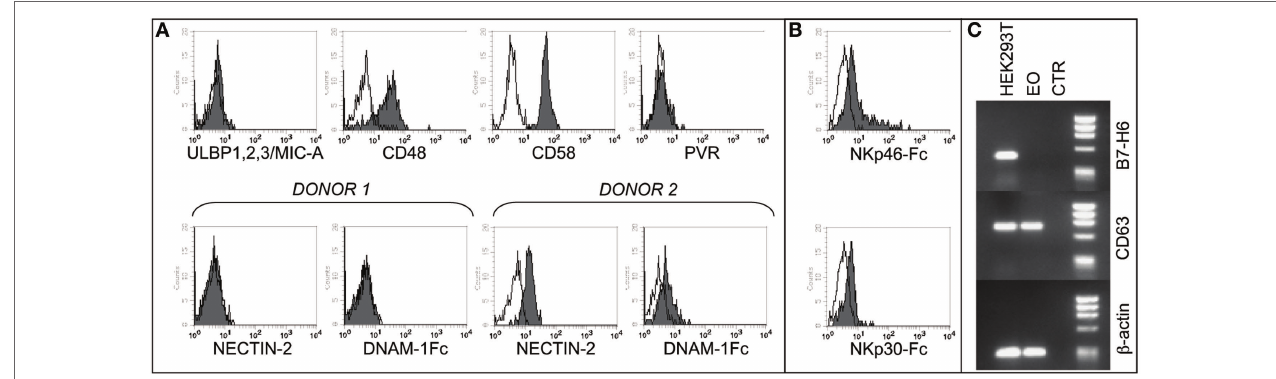
FigUre 1 | analysis of nK cell receptor ligands on eosinophils (eOs) freshly purified from healthy non-atopic donors . (a) EOs were analyzed for the cell surface expression of NK cell receptor ligands including ULBP1,2,3, MIC-A, CD48, CD58, and PVR. A representative donor out of 15 is shown (upper line). The expression of Nectin-2 and, as control, the staining with DNAM-1-Fc* soluble molecule are shown for two representative donors out of 20 analyzed (lower line). Open profiles indicate staining with the corresponding PE-conjugated anti-mouse or anti-human secondary reagents. (B) EOs were analyzed for the cell surface binding of NKp30-Fc* and NKp46-Fc* soluble molecules. Open profiles indicate staining with PE-conjugated anti-human IgG secondary reagent. A representative donor out of six is shown. (c) B7-H6 mRNA expression was assessed by RT-PCR in EOs and in HEK293T cell line. PCR products were run on a 0.8% agarose gel and visualized by ethidium bromide staining. RT-PCR was also performed with primers specific for CD63 and β -actin as positive